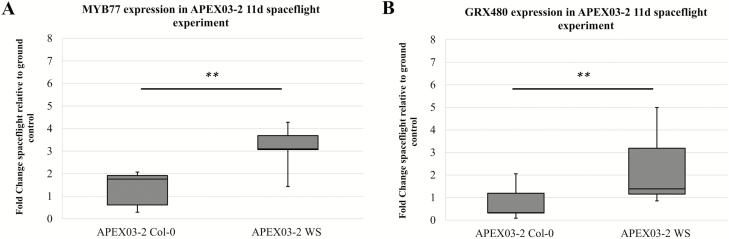

MYB77 and GRX480 expression of APEX03-2 spaceflight experiment showed higher fold change in WS compared to the Col-0 ecotype. (A) qRT-PCR done on APEX03-2 11d spaceflight root tissue show that MYB77 transcript in spaceflight relative to ground controls is significantly (P = 0.001) different between WS and Col-0 plants. The fold change of MYB77 expression is higher in the WS ecotype compared to the Col-0 ecotype. (B) qRT-PCR showed a significant (P = 0.007) difference in the expression fold change of GRX480 between Col-0 and WS plants. Boxplots were derived from nine replicates normalized to UBQ11 and plotted spaceflight relative to ground control. ** indicate (P < 0.01) significant difference between Col-0 and WS was calculated by doing a Student’s t-test.